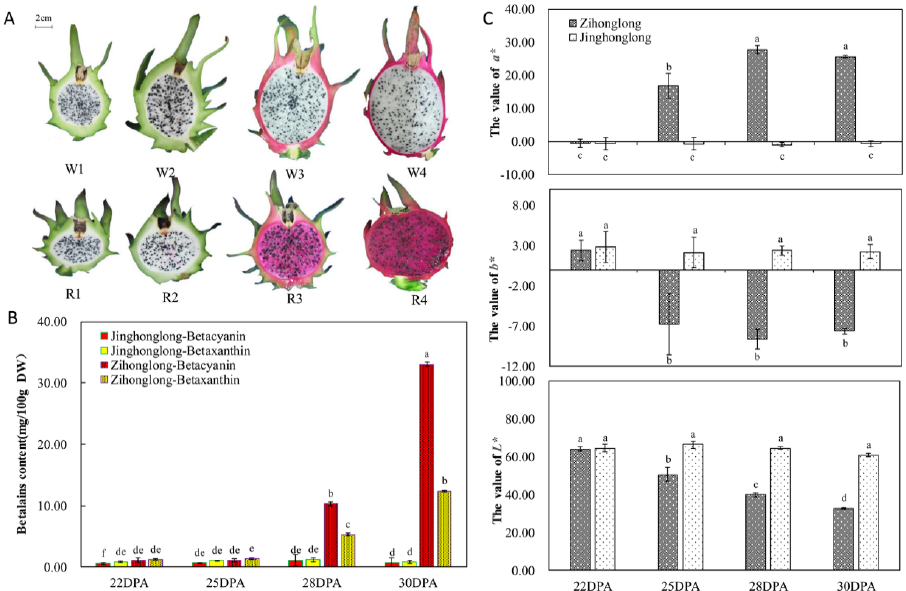
Figure 1. The variation of parameters related to pigmentation ( A ), Pulp color in four fruit